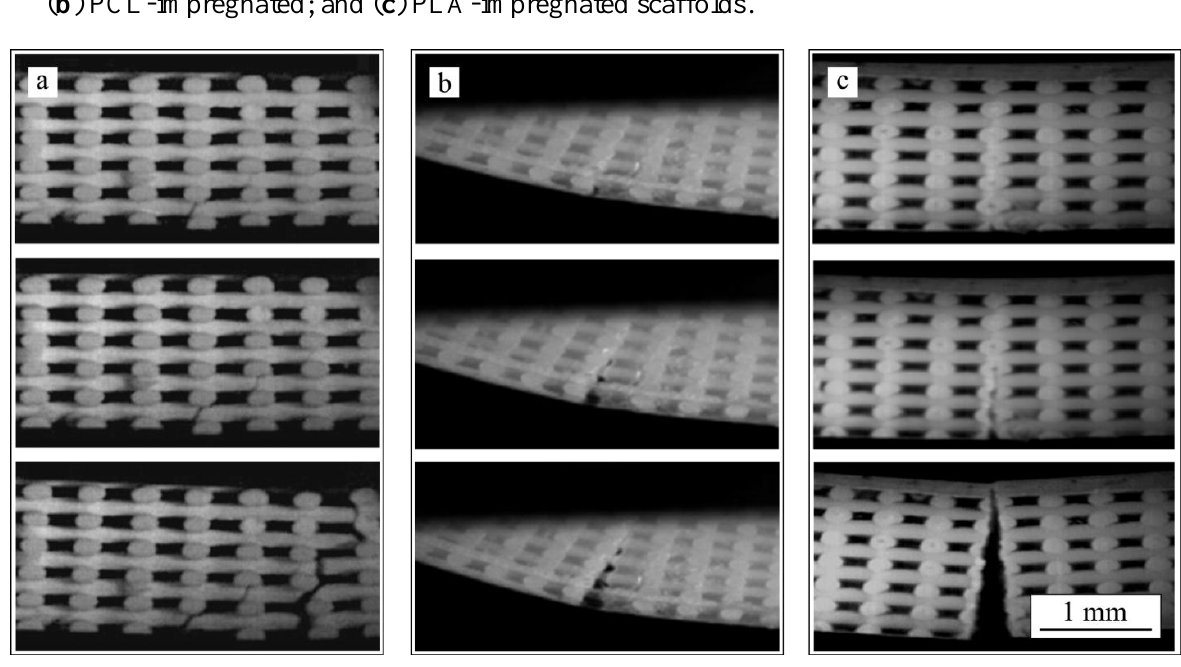
Figure 2. Optical image sequences captured in situ showing the evolution of damage during 4-point bending tests performed in the direction orthogonal to the rods (rods appear aligned from left to right and perpendicular to the image) on ( a ) bare β-TCP; ( b ) PCL-impregnated; and ( c ) PLA-impregnated